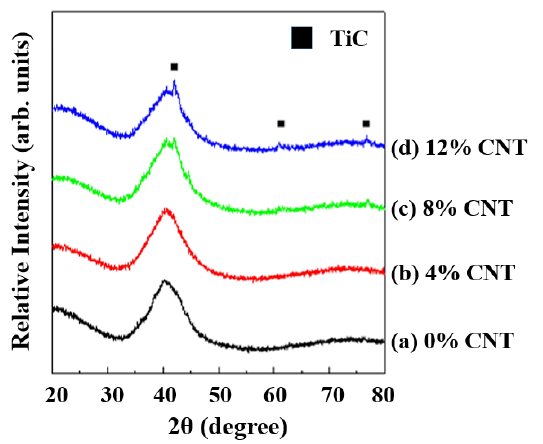
Figure 1. X-ray diffraction (XRD) patterns for mechanically alloyed Ti 50 Cu 28 Ni 15 Sn 7 and composite powders after 8 h milling: (a) 0% carbon nanotube (CNT); (b) 4% CNT; (c) 8% CNT; (d) 12% CNT.